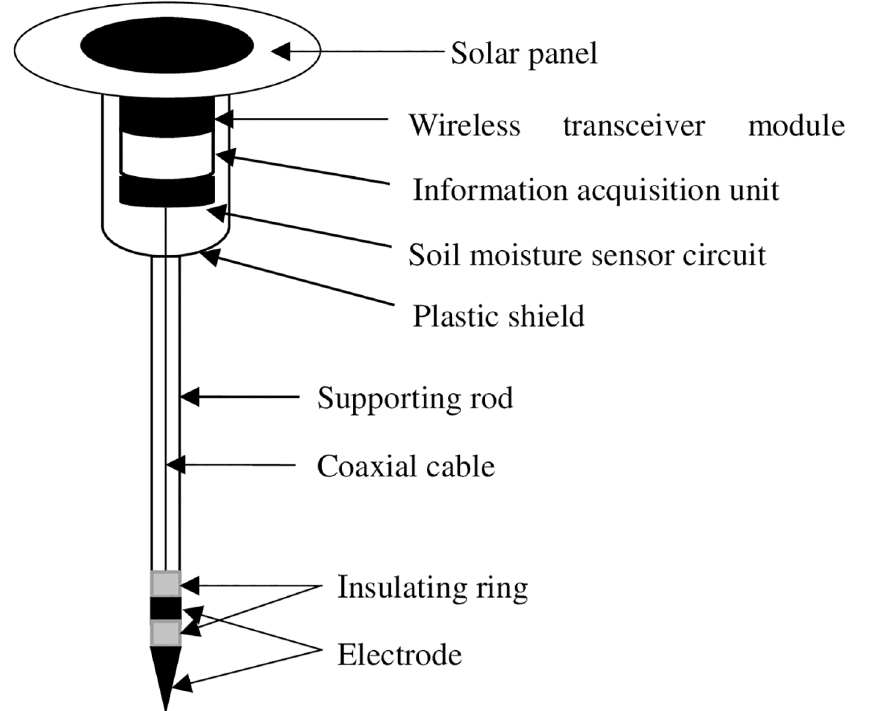
Fig 1. Layout of solar-powered wireless sensor.